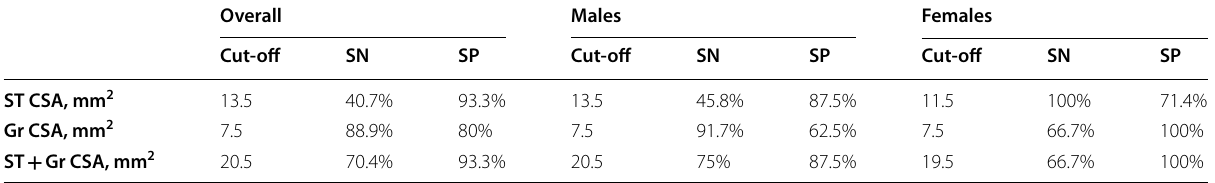
STT CSA Cross-sectional area of semitendinosus tendon, Gr CSA Cross-sectional area of gracilis tendon, SN Sensitivity, SP Specificity